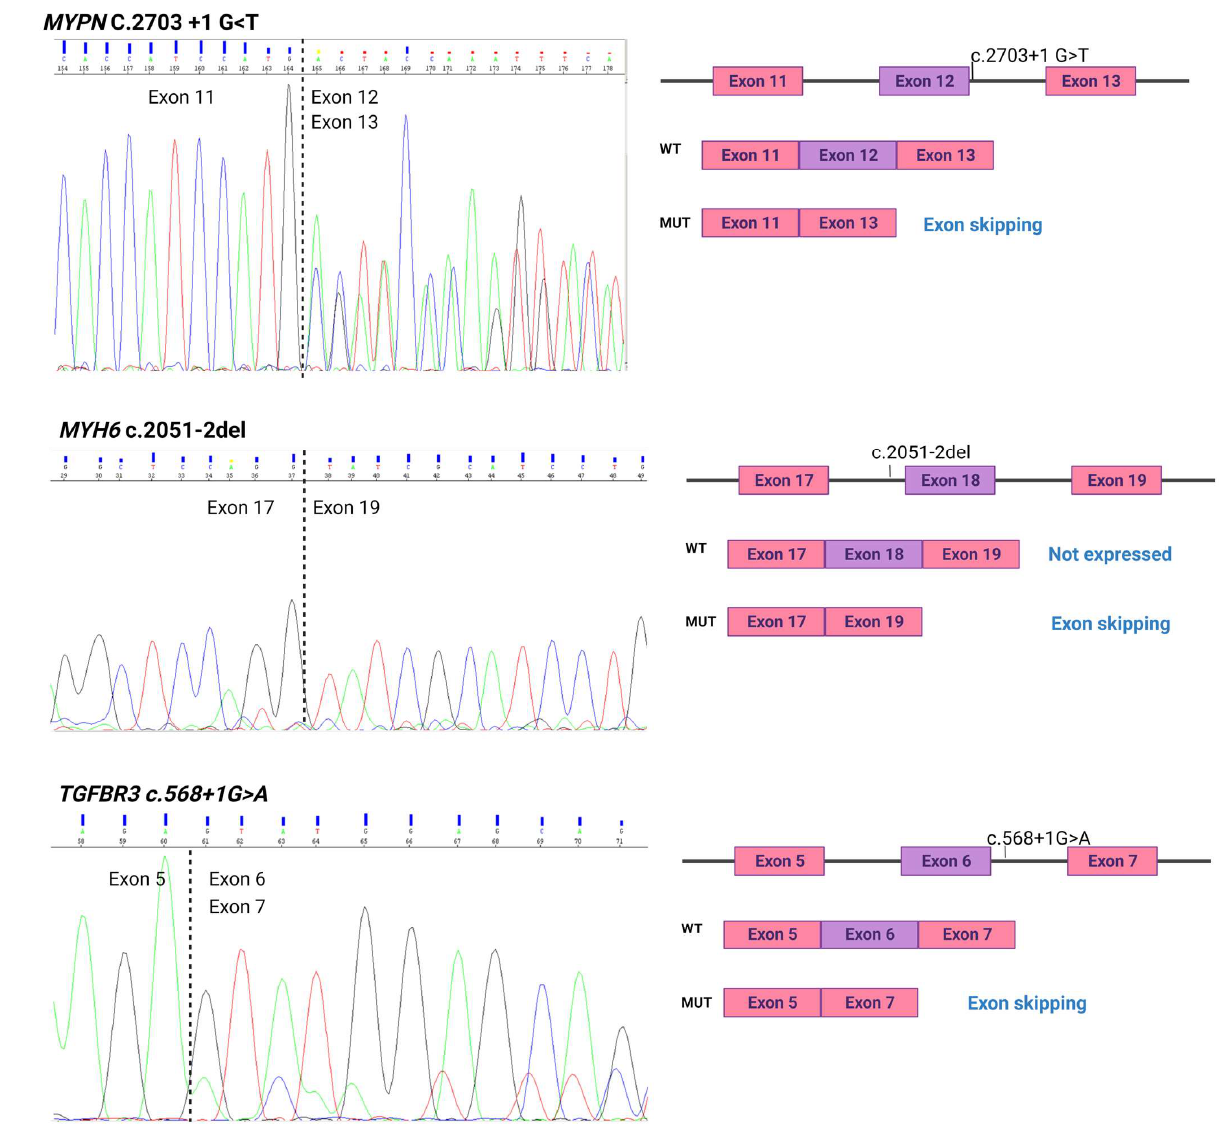
Figure 2. Aberrant splicing products identified for the most classical canonical variants.